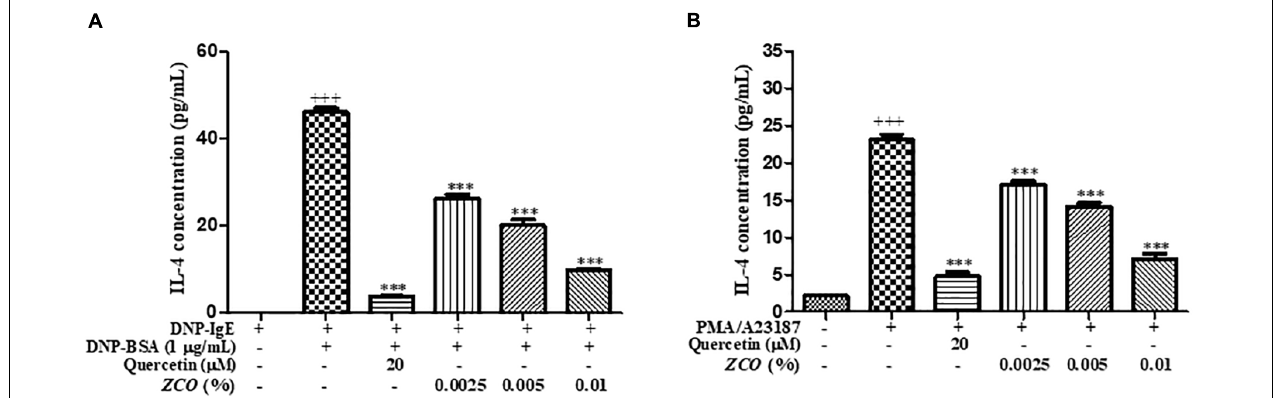
FIGURE 3 | Effect of ZCO on IL-4 production in RBL-2H3 cells. (A) RBL-2H3 cells were sensitized with IgE overnight at 37 ◦ C, followed by pretreatment with ZCO (0.0025, 0.005, and 0.01%) or quercetin (20 µ M) for 2 h before stimulation with 1 µ g/mL DNP-BSA for 16 h. The supernatants were analyzed for IL-4 production. Experiments were conducted in quadruplicate and expressed as mean ± SEM ( ∗∗∗ P < 0.001 versus with DNP-BSA group). (B) RBL-2H3 cells incubated into 48-well plate overnight were pretreated with ZCO or quercetin for 2 h prior to stimulation with 30 ng/mL of PMA plus 350 ng/mL of A23187 for 16 h. The supernatants were collected and IL-4 cytokine was tested by using ELISA kit ( ∗∗∗ P < 0.001 versus with PMA/A23187 group). +++ means the significance compared with the mock cells (deal with